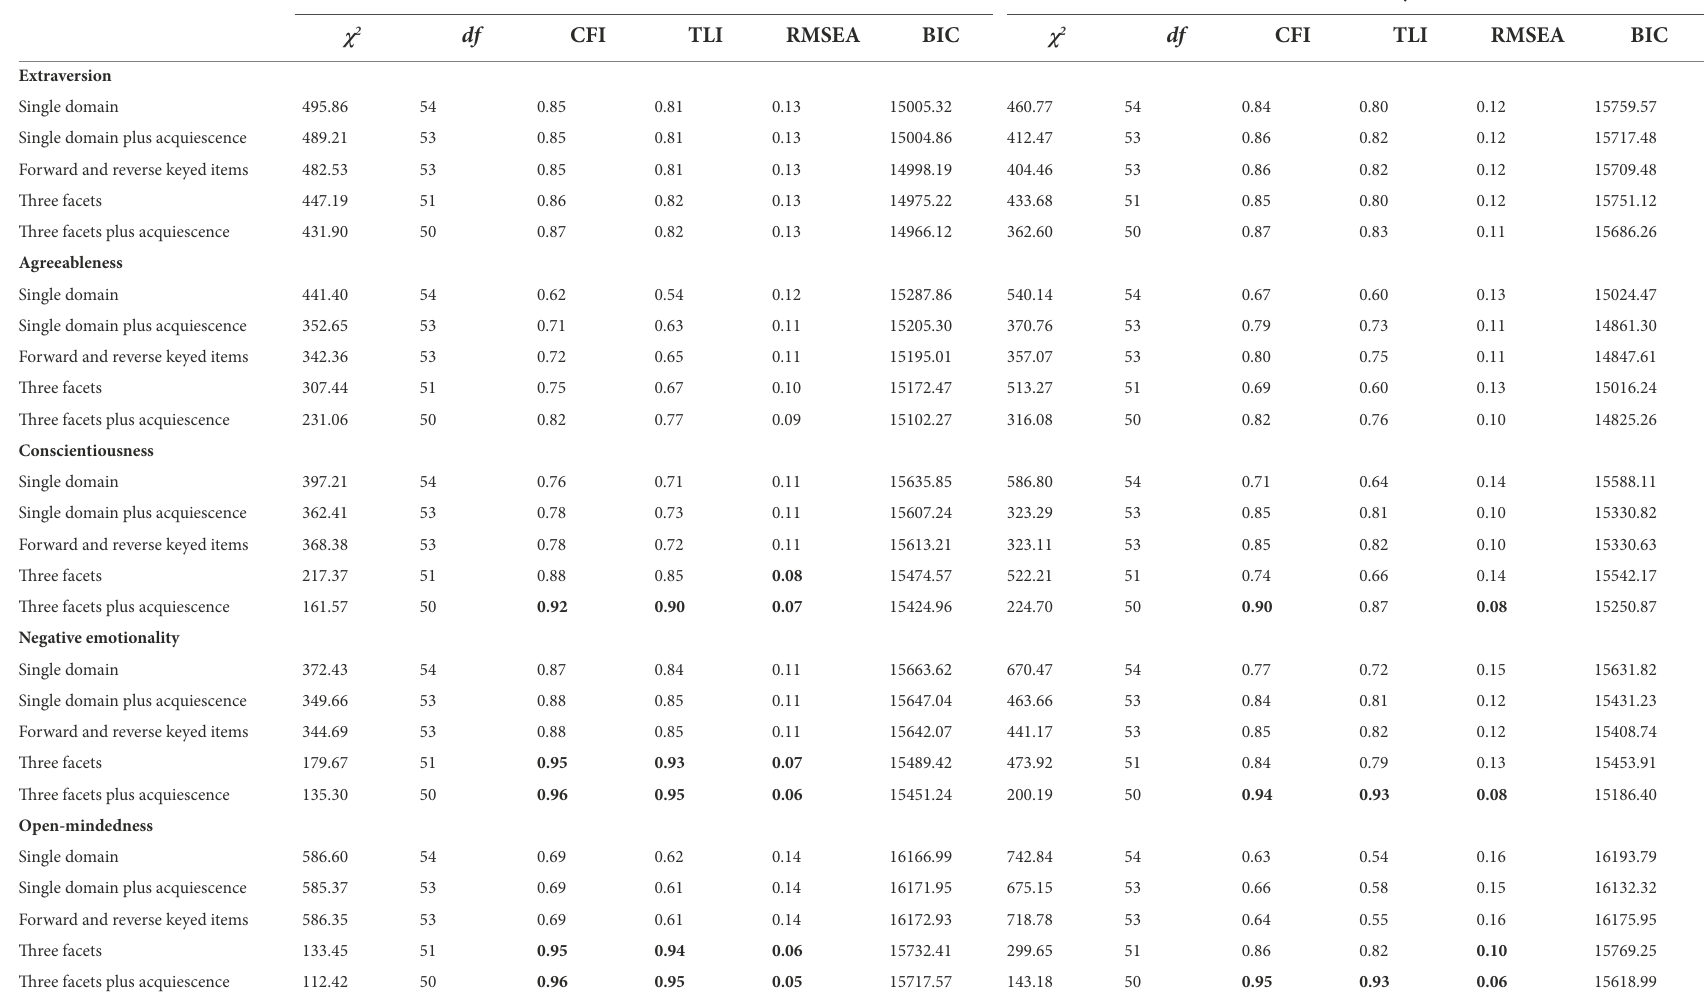
TABLE 4 Fit statistics for confirmatory factor analyses of BFI-2-J